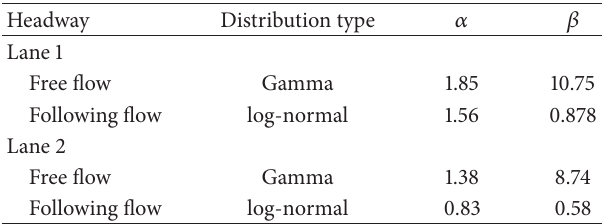
Table 5: Probability distribution types and parameters for the